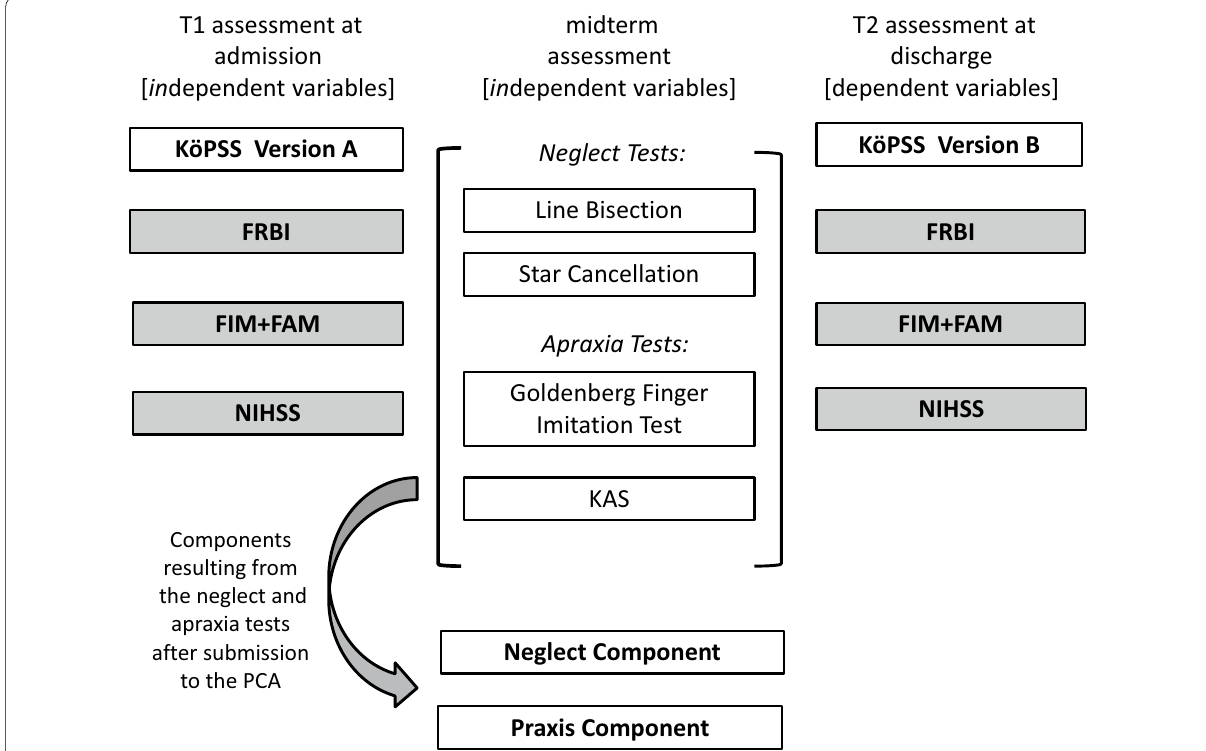
Fig. 2 Conceptual model of the independent (T1 and midterm assessment) and dependent variables (T2). The diagram displays the different assessments performed after admission to the rehabilitation ward, at midterm and before discharge from the rehabilitation ward. Cognitive assessments are presented in white boxes and, functional assessments in grey boxes. The assessments at T1 and midterm served as independent variables and the assessments at T2 as the dependent variables in the statistical evaluation (here: multiple regression analysis with bootstrapped